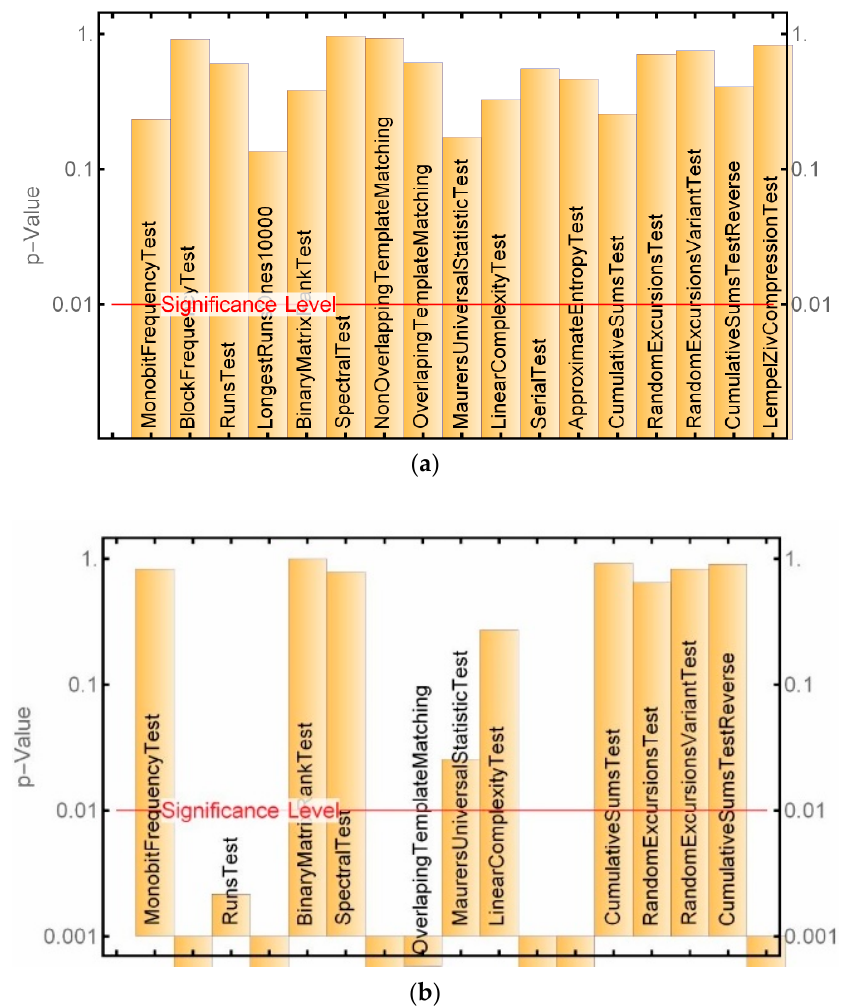
Figure 6. National Institute of Standards and Technology (NIST) test results for a sequence generated by: ( a ) the proposed algorithm; ( b ) an algorithm that only uses the STM.